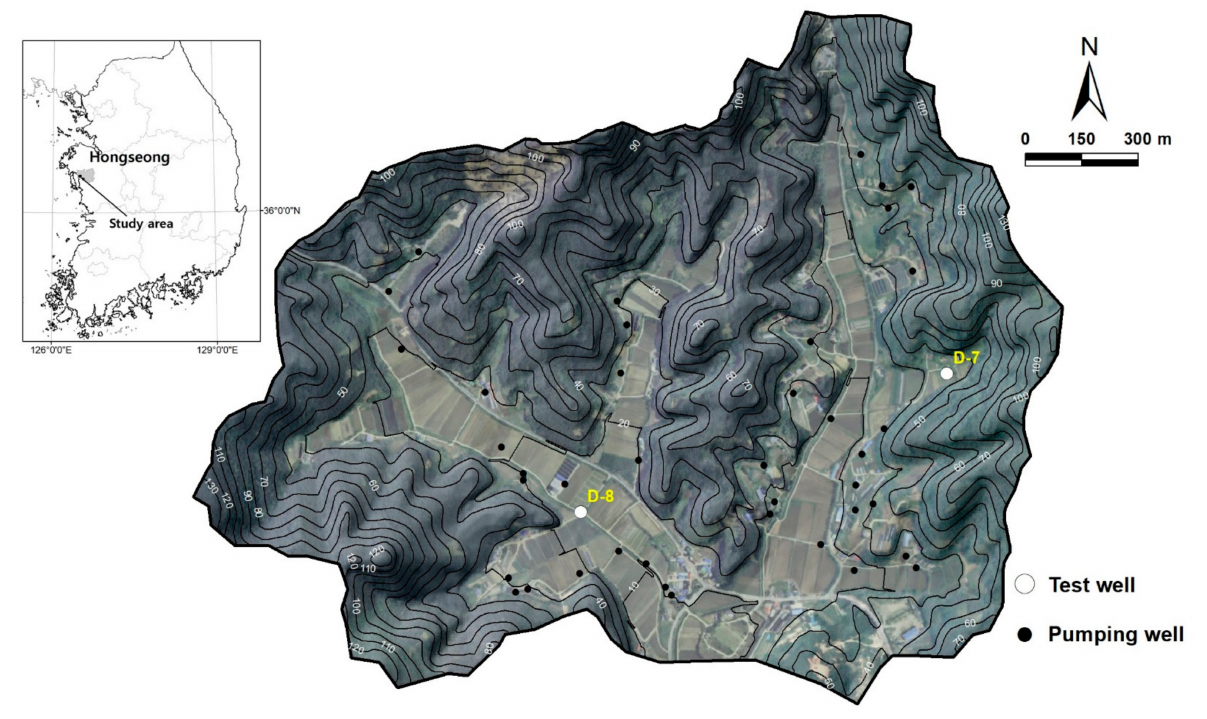
Figure 1. Study area and well